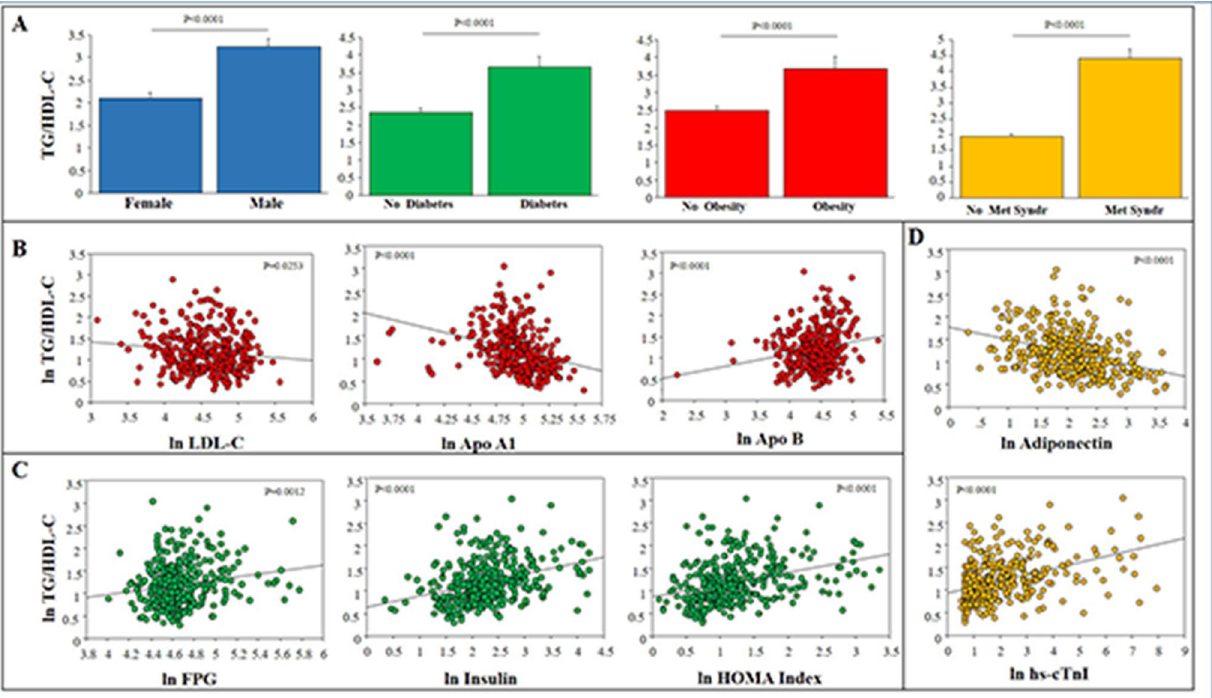
Figure 1. TG/HDL-C ratio and cardio-metabolic risk. Relationship between baseline TG/HDL-C ratio, specific cardiovascular risk factors (Panel A ), and relevant bio-humoral variables (Panel B , C , D